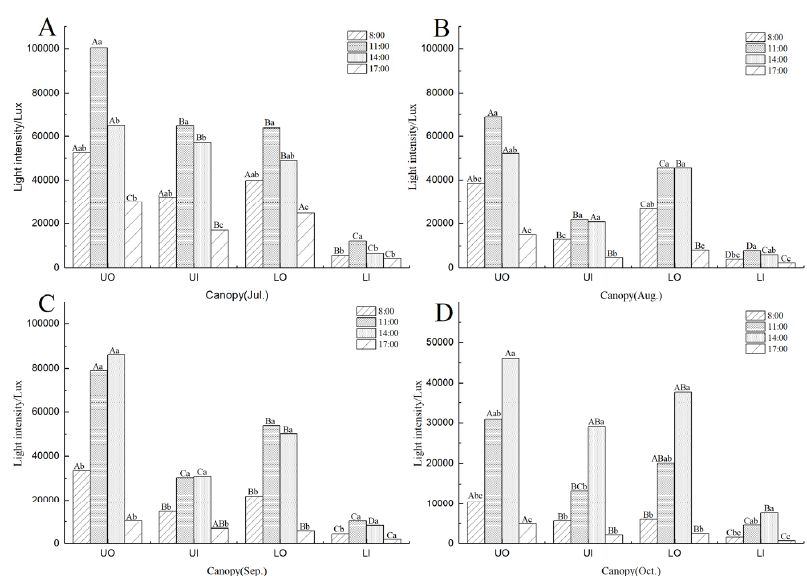
Figure 7. Light intensity in canopies at different times in the day in ( A ) July, ( B ) August, ( C ) September, ( D ) October. Different uppercase and lowercase letters indicate significant differences ( p ≤ 0.05; Duncan’s multiple range tests) between locations and times, respectively. Table 1. The variations of temperature ( °C ) at different times of the day in different canopy posi- tions.